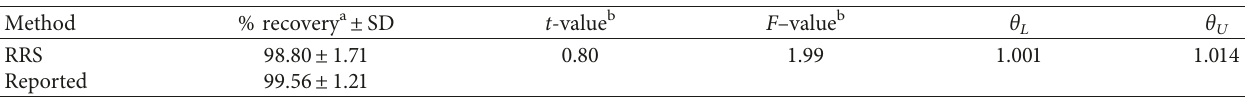
Table 3: Estimation of NEO in veterinary drugs (QianFang animal protection technology Co., Ltd.) by the proposed spectroscopic method.